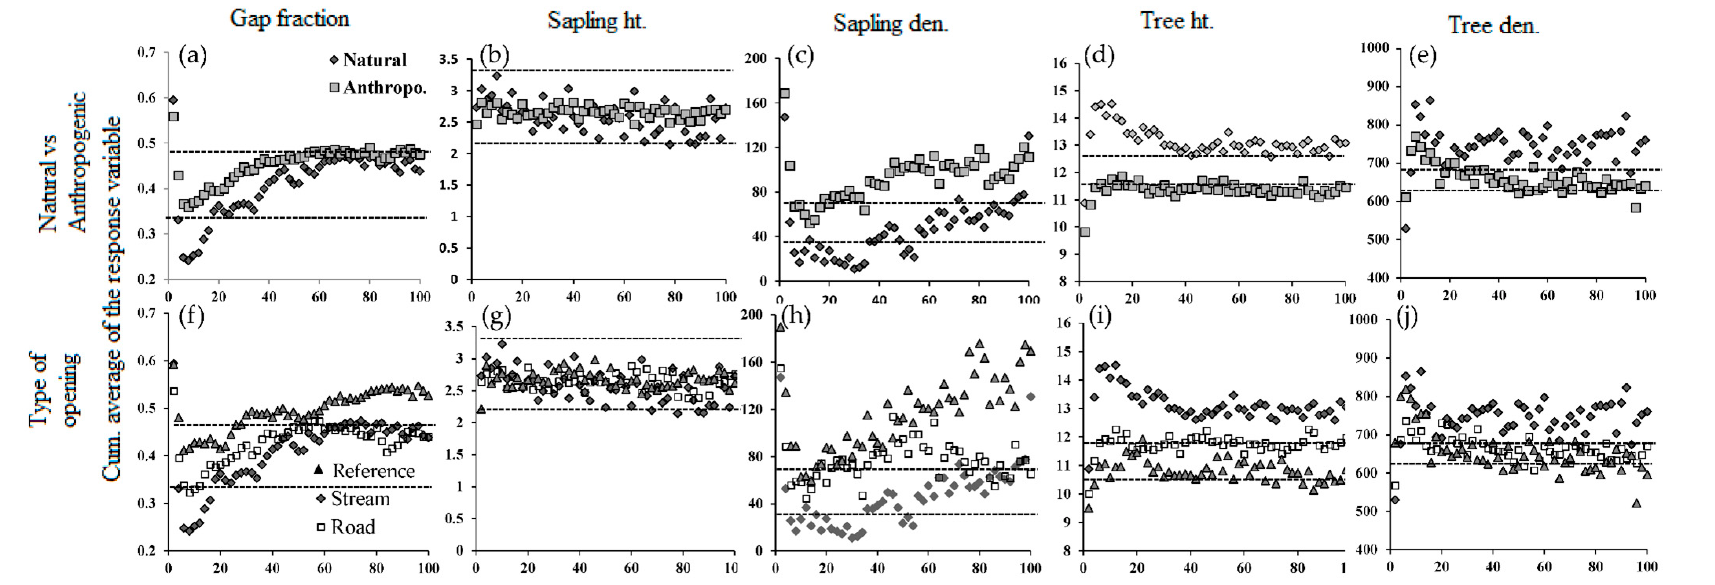
Figure 4. Mean values of the response variables (listed in the heading of each column) with distance from the edge of a linear opening; ( a – e ) when compared to the reference forest; ( f – j ) between the types of linear openings. The dashed lines indicate the critical values of the response variables determined by bootstrap sampling for the reference forest. Significant values are those that occur outside the critical band.